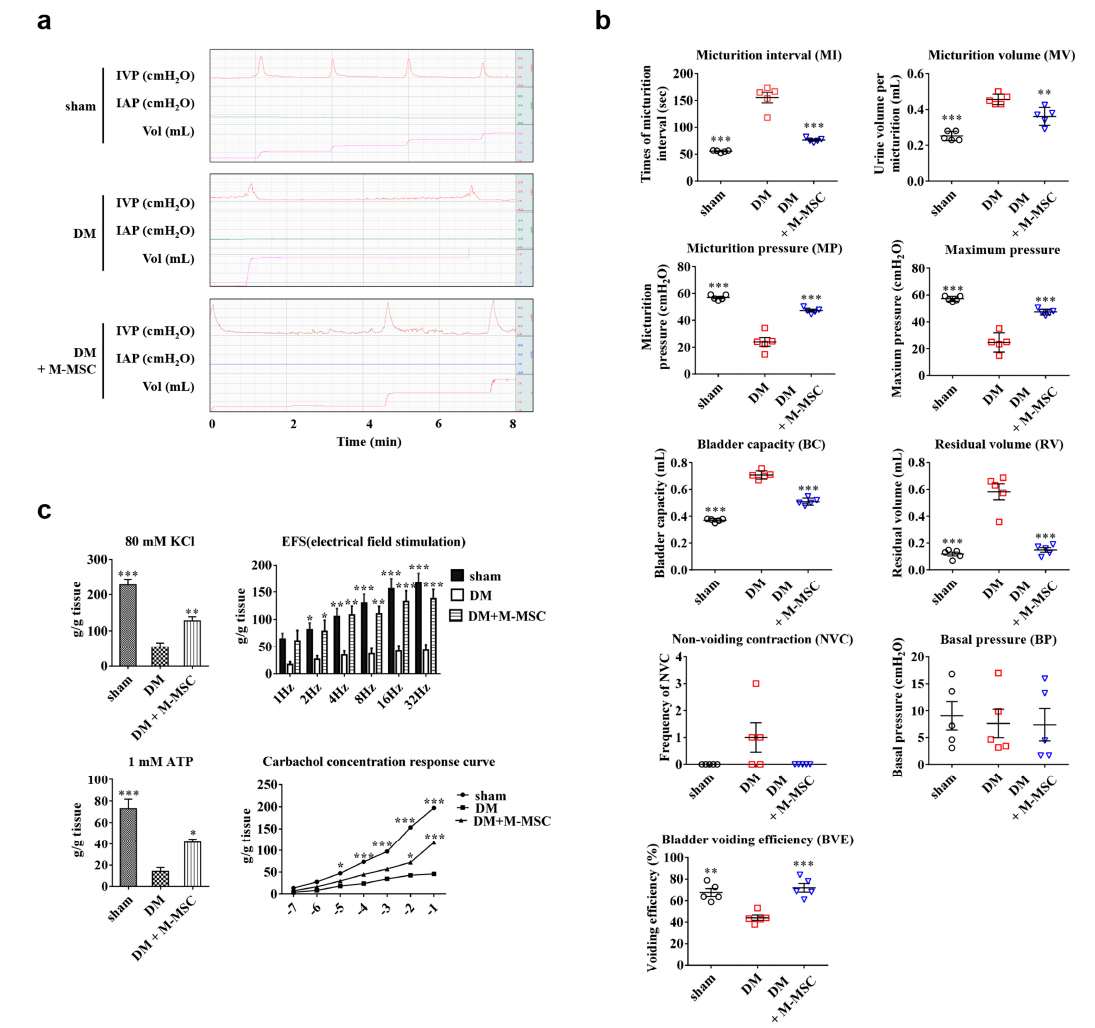
Figure 1. M-MSC transplantation ameliorated voiding function in DM rats. ( a ) Representative awake cystometry results and ( b ) quantitative voiding data 1 week after injection of diabetes mellitus (DM) rats with 1 × 10 6 M-MSCs (1000 K) from five independent animals per group. Sham: non-diabetic sham-operated. ( c ) Organ bath study analysis (n = 5 animals / group) to assess contractile response to 80 mM KCl, frequency response to EFS, contractile response to 1 mM ATP, and concentration response curve for carbachol. Data are presented as mean ± SEM. (* p < 0.05, ** p < 0.01, and *** p < 0.001 relative to DM group, one-way or two-way ANOVA with Bonferroni post-hoc comparison). The exact experimental and statistical values can be found in the Supplementary Table. DM: diabetes mellitus; M-MSC: Multipotent-mesenchymal stem cell; EFS: Electrical field